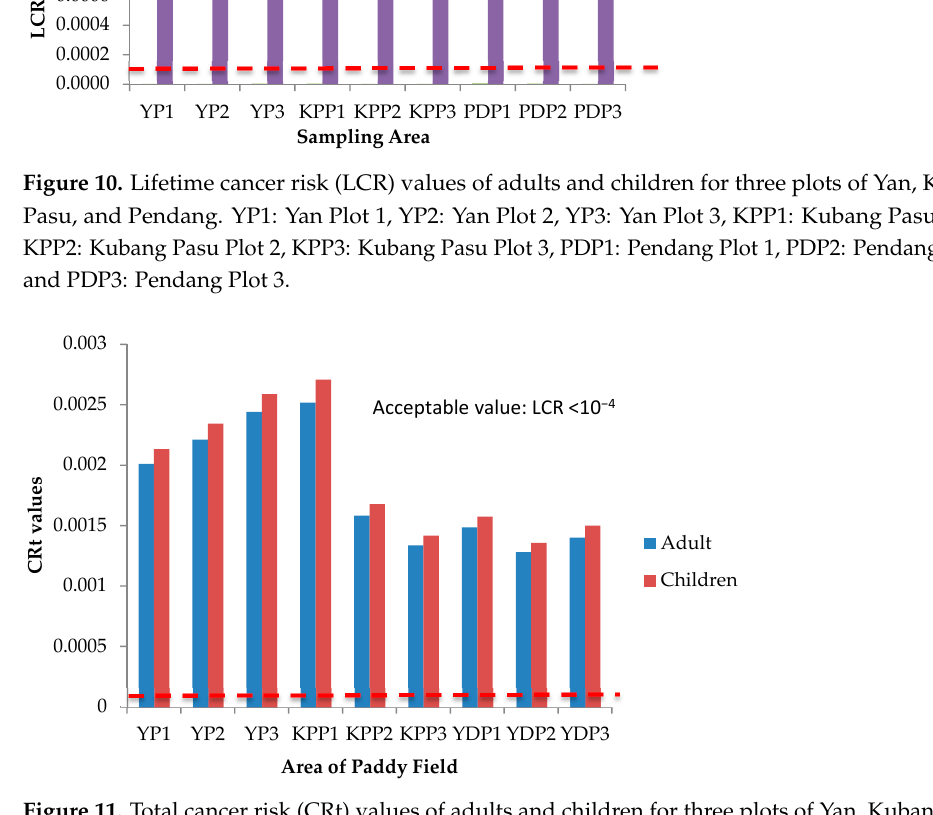
Figure 11. Total cancer risk (CRt) values of adults and children for three plots of Yan, Kubang Pasu, and Pendang. YP1: Yan Plot 1, YP2: Yan Plot 2, YP3: Yan Plot 3, KPP1: Kubang Pasu Plot 1, KPP2: Kubang Pasu Plot 2, KPP3: Kubang Pasu Plot 3, PDP1: Pendang Plot 1, PDP2: Pendang Plot 2, and PDP3: Pendang Plot 3.